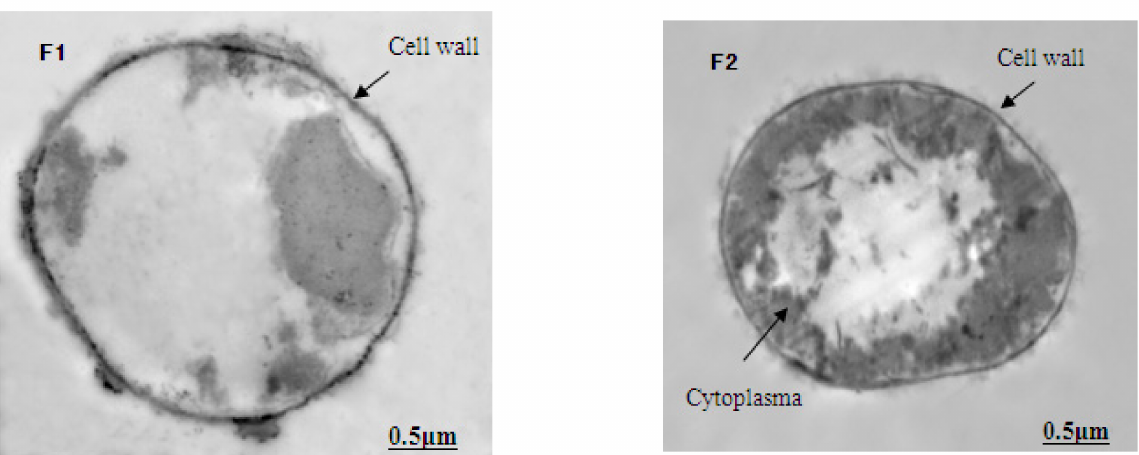
Figure 3. Effect of Lindane on the cellular ultrastructure of M. aeruginosa (7000 × ): ( A – F ): ultra- structure of M. aeruginosa in 0, 50, 89, 158, 281 and 500 µ g/L Lindane, respectively; 1-cell growth, 2-cell division. ( A ) shows cyanophycin granules, nucleoid and phosphate granules; ( B ) shows thy- lakoid and phosphate granules; ( C ) shows thylakoid, phosphate granules and nucleoid; ( D ) shows cyanophycin, thylakoid and phosphate granules; ( E ) shows cytoplasm, thylakoid and cell wall; ( F ) shows cell wall and cytoplasm.